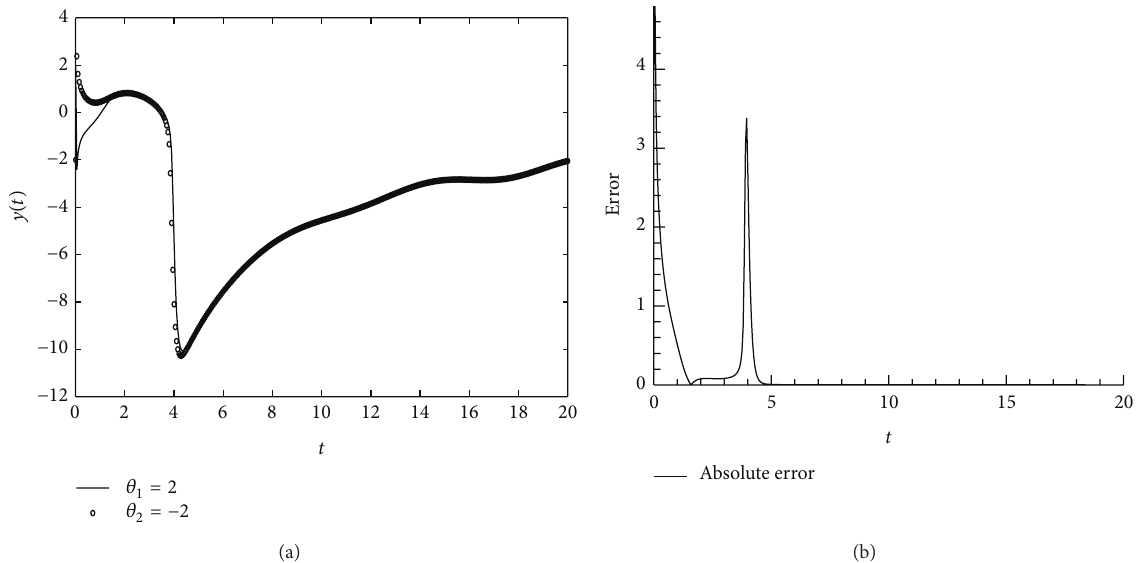
Figure 7: The numerical results of the problems (110) and (111); ℎ = 0.5 , 𝛼 = 0.8, 𝜃 1 = 2.0, 𝜃 2 = −2.0, 𝜙 1 = 0.9, 𝜙 2 = 0.98 .